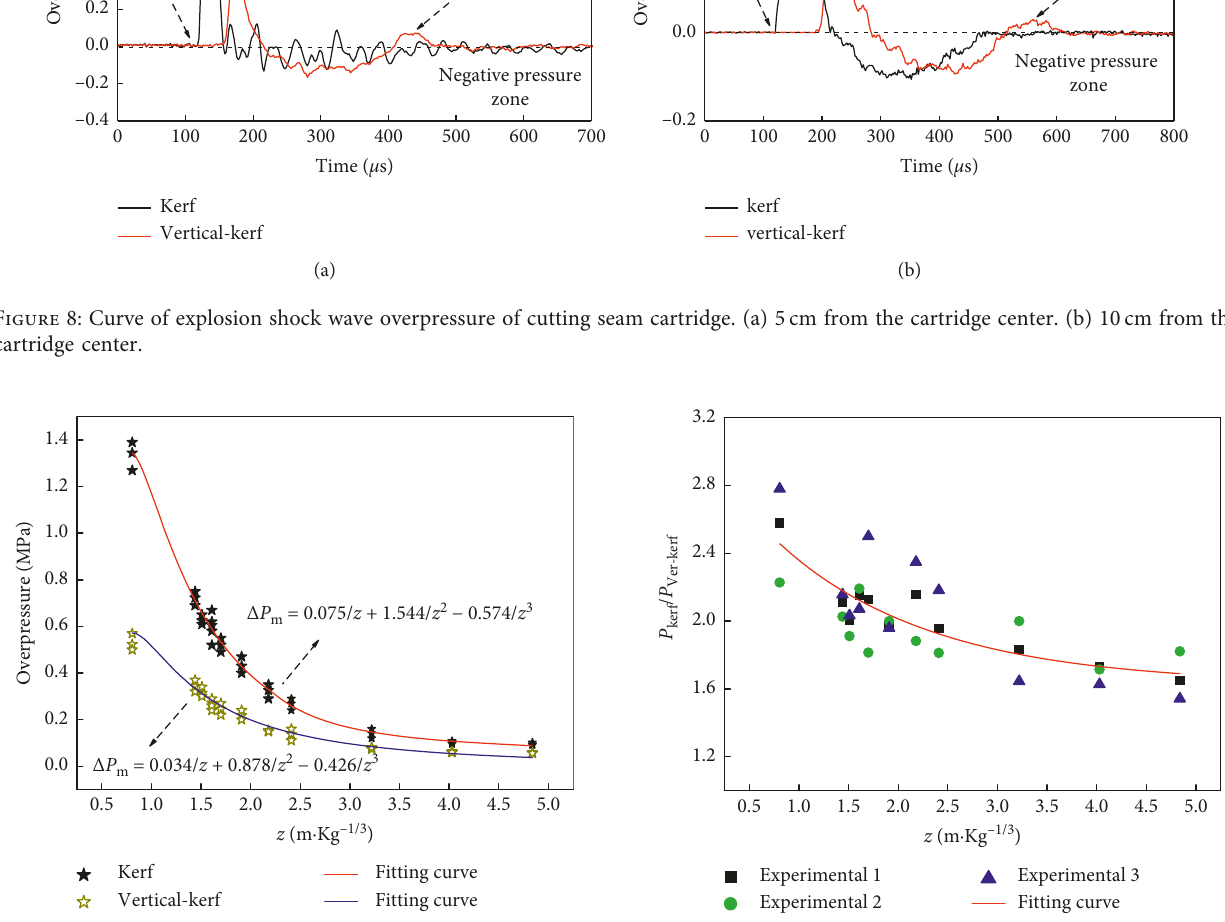
Figure 10: Curve of the peak pressure ratio between cutting seam direction and vertical cutting seam direction.